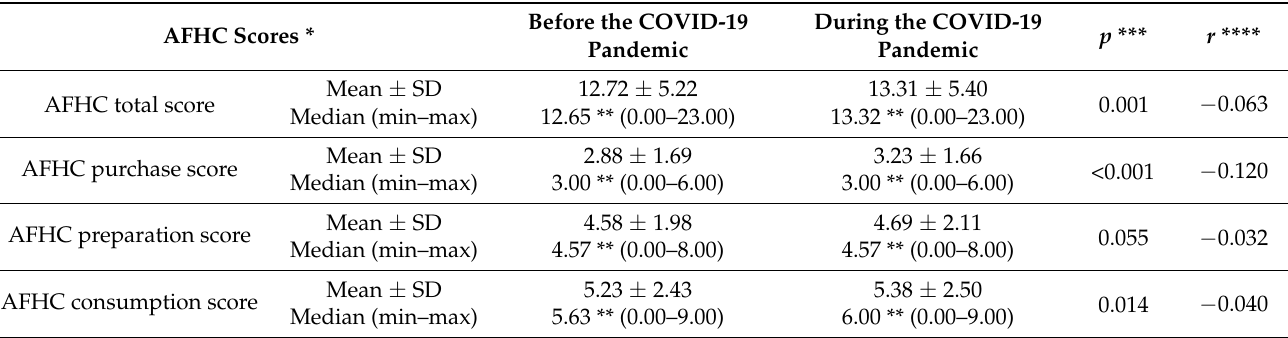
Table 5. The dietary habits scores calculated on the basis of the Adolescents’ Food Habits Checklist (AFHC) for purchase, preparation, consumption and total habits, within the PLACE-19